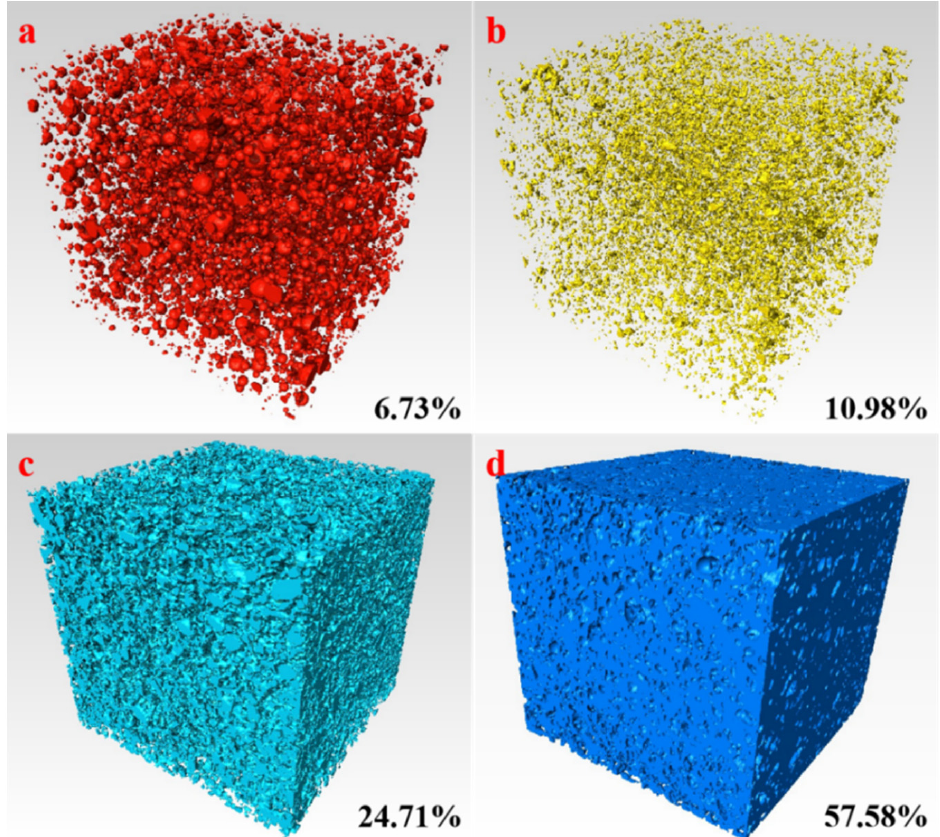
Figure 11. Three dimensional distribution of different components of AACM specimen. (( a ): pore, ( b ): mineral, ( c ): aggregate particle, and ( d ): other matrix material).